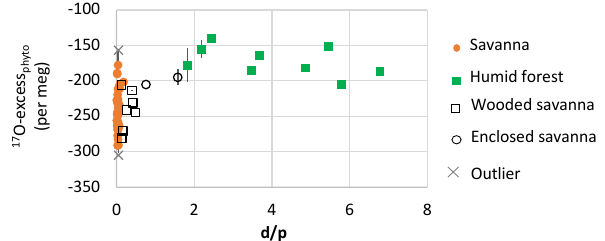
Figure 5. Natural West and Central African transect: 17 O-excess of phytoliths ( 17 O-excess Phyto ) vs. d/p